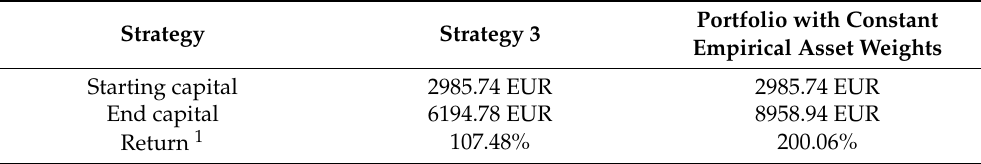
Figure 7. The development of the wealth process of Strategy 3 (orange) and the portfolio with the constant empirical low-risk asset weights (green). Table 6. Performance comparison of the empirical lower-risk strategy and the constant empirical asset weighted